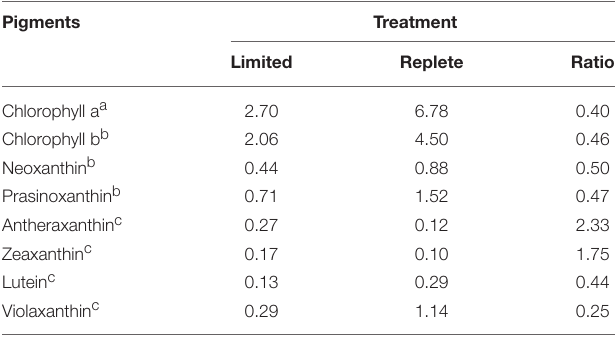
TABLE 2 | Steady state phytoplankton pigment composition in non-infected Fe-limited (first column) and Fe-replete (second column) M. pusilla